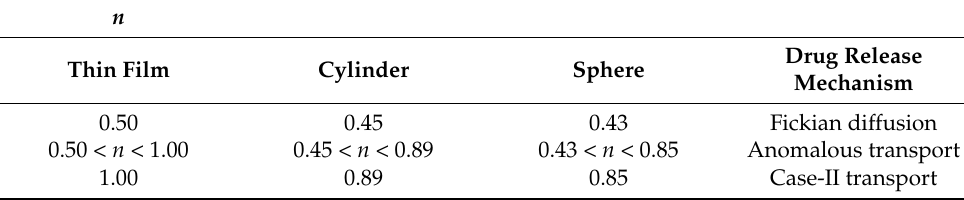
Table 2. Characterization of the diffusion exponent n depending on the dosage form